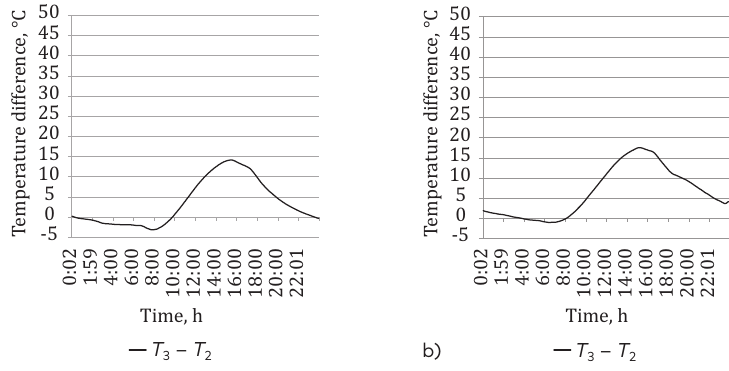
Figure 7. Temperature difference between the top slab and bottom slab T 3 − T 2 ; a) 1 April 2019, b) 26 June